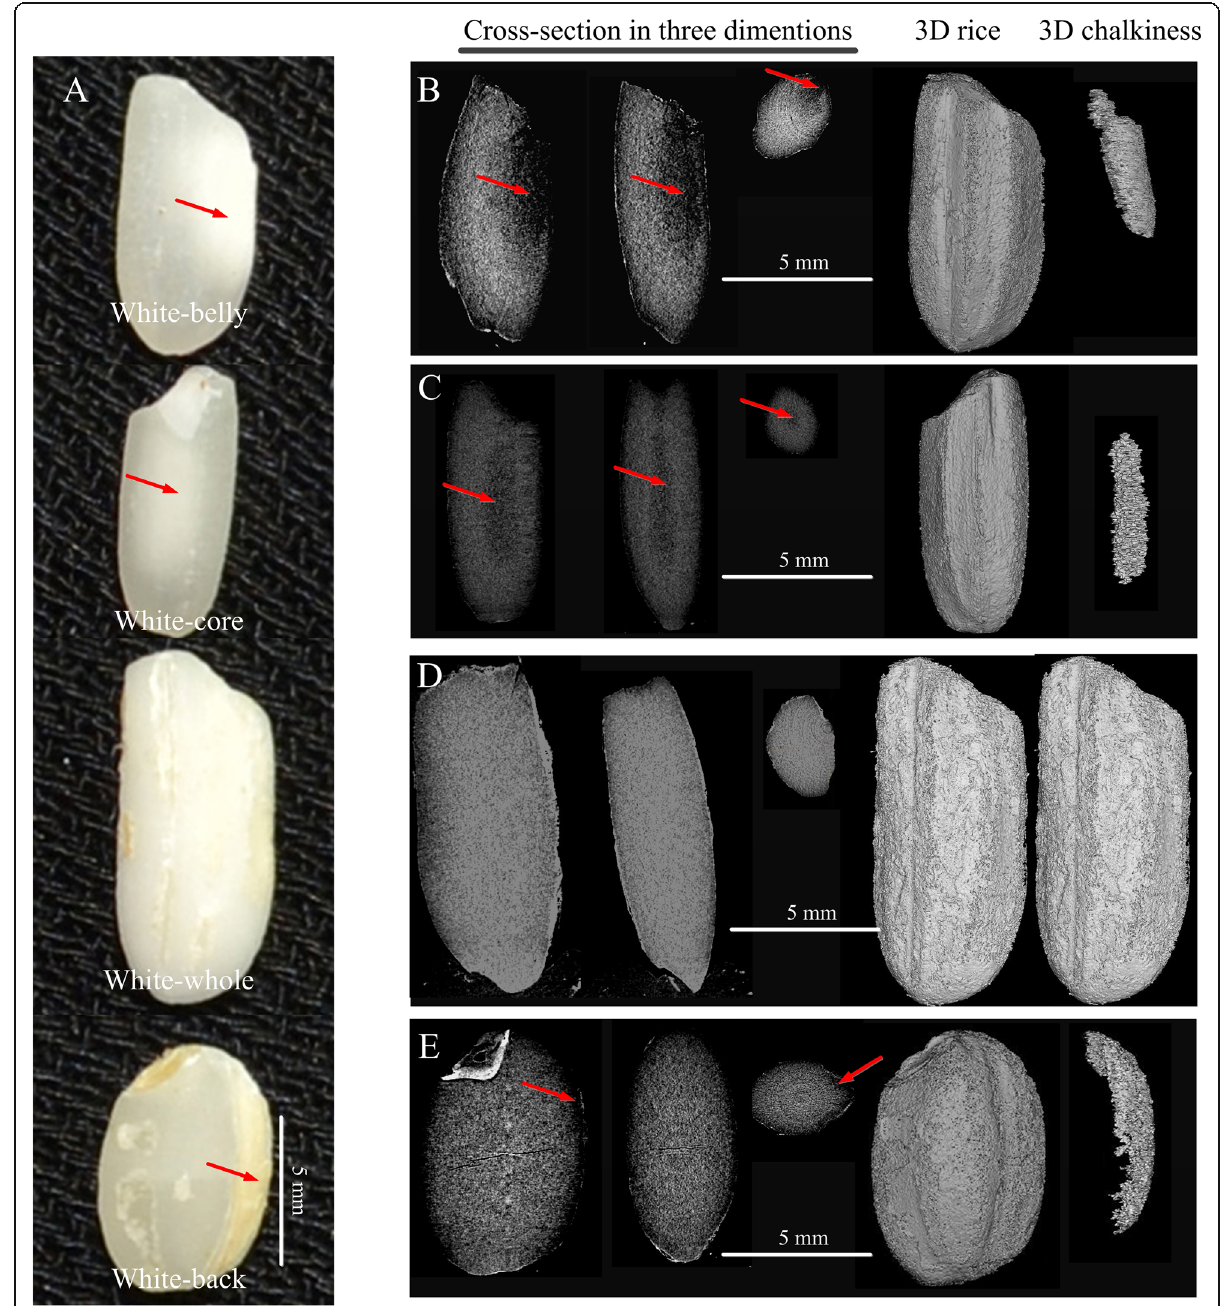
Fig. 3 The shape and location of rice chalkiness. a milled rice with chalkiness of white-belly (X220), white-core (X226), white-whole (Xiangzaoxian) and white-back (X191) respectively; Cross-section images, reconstructed 3D rice images and reconstructed 3D chalkiness images of milled rice with chalkiness of white-belly ( b ), white-core ( c ), white-whole ( d ) and white-back ( e ) respectively. Dark areas indicated by red arrows represent the location of rice